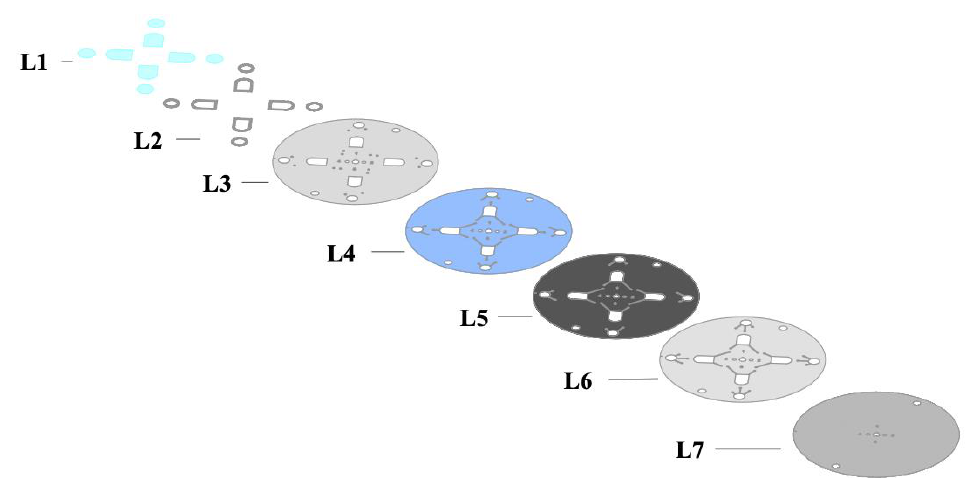
Figure 4. Schematic describing the individual layers of the microdevice used in these experiments. Layer L1 is the PET layer used to seal microfluidic chambers. L2 shows the PMMA segments used to increase the capacity of the fluidic chambers. L3 and L7 represent PET layers. L4 and L6 represent PET coated with HSA. L5 represents a black PET layer that serves as a barrier between fluidic channels until laser actuation.